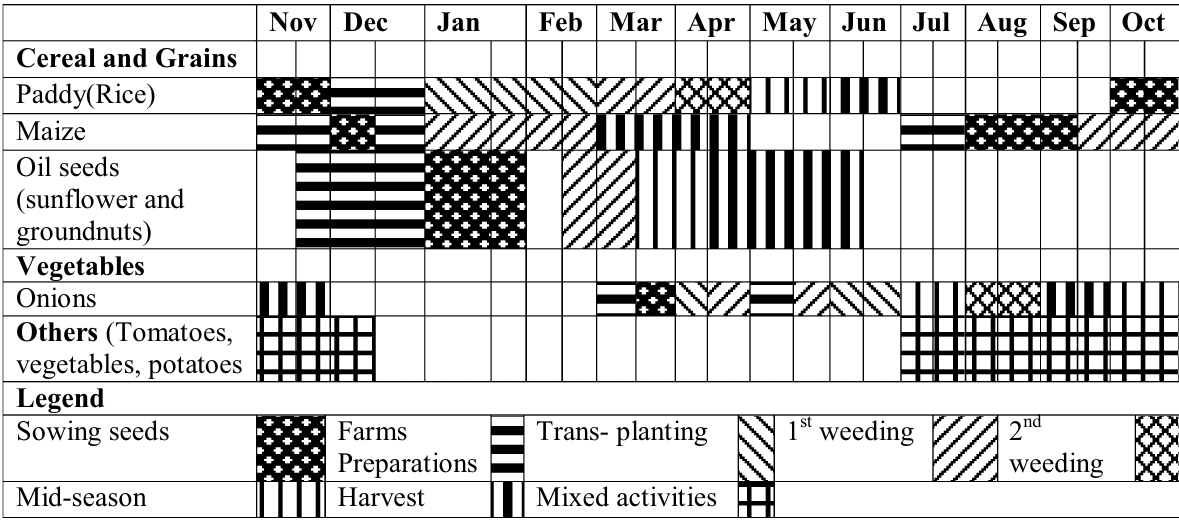
Table 1 Crops growing calendar in Usangu Basin in a hydrological